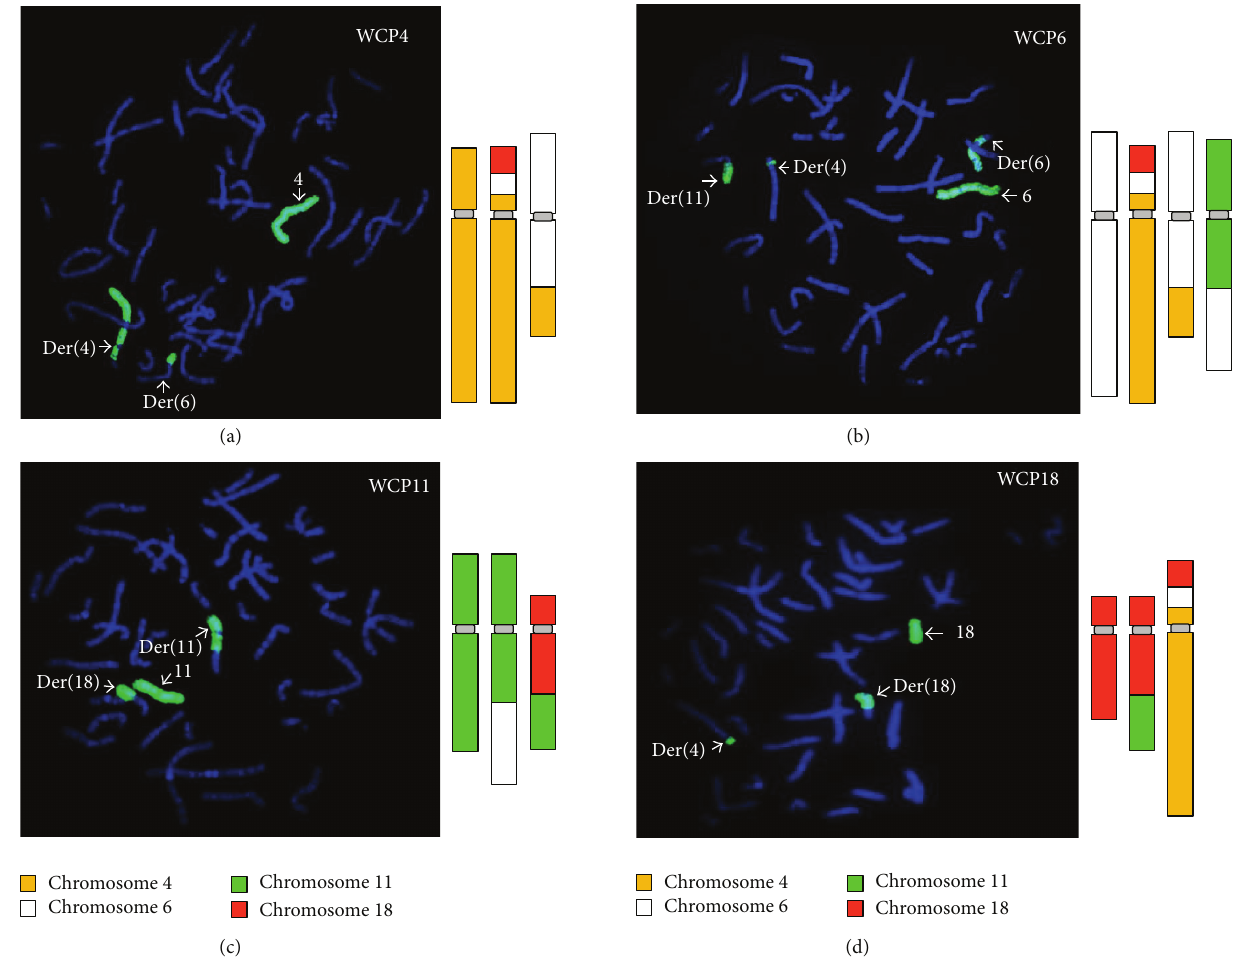
Figure 3: Whole chromosome painting FISH: (a) chromosome 4, (b) chromosome 6, (c) chromosome 11, and (d) chromosome